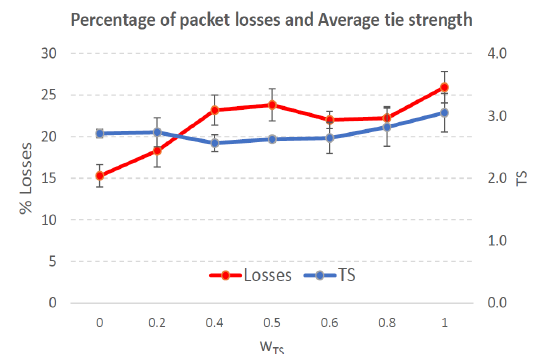
Figure 14. Percentage of packet losses and average tie strength of the forwarding path. Scenario with high social media interaction (TS normal distribution with µ = 3 and σ = 1). Nodes’ density = 200 nodes/km 2